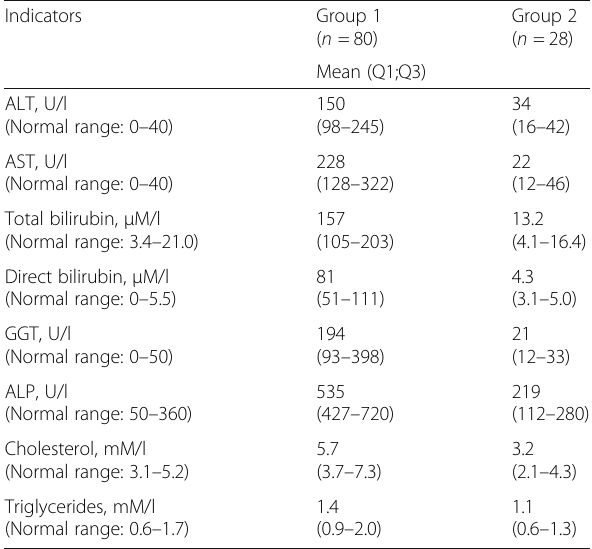
Table 1 Markers of liver function at the time of C-triol and ChT